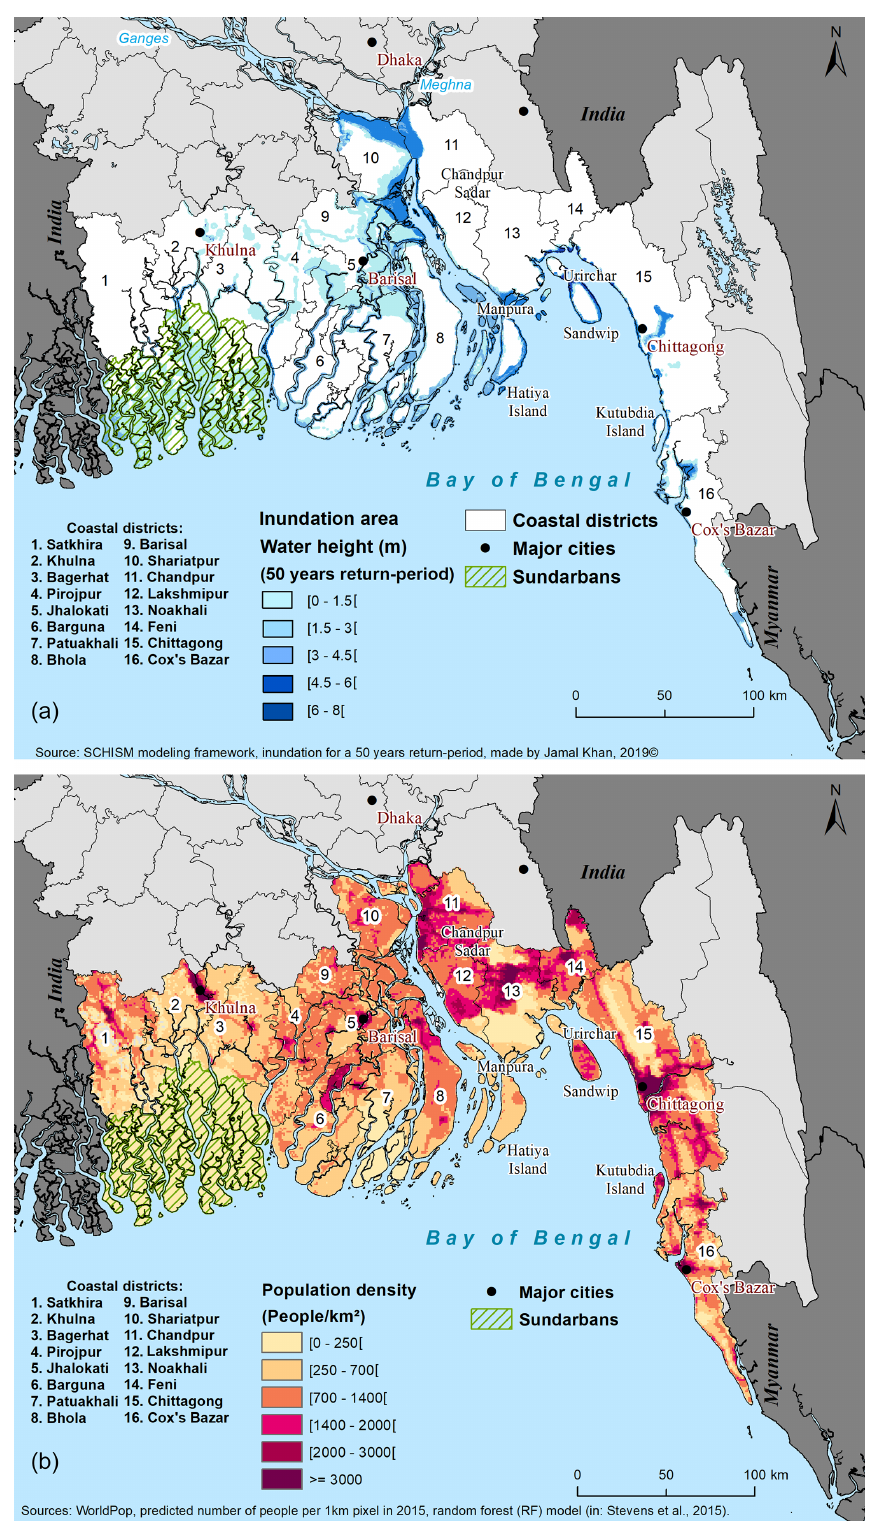
Figure 1. Study area. (a) Cyclonic inundation level with a 50-year return period estimated from a large number of hydrodynamic simulations (Khan et al., 2019). This means that at a particular location, the reported flooding height, due to cyclonic surges, is expected to be observed once in 50 years. (b) Population density in coastal districts of Bangladesh. SCHISM: Semi-implicit Cross-scale Hydroscience Integrated System